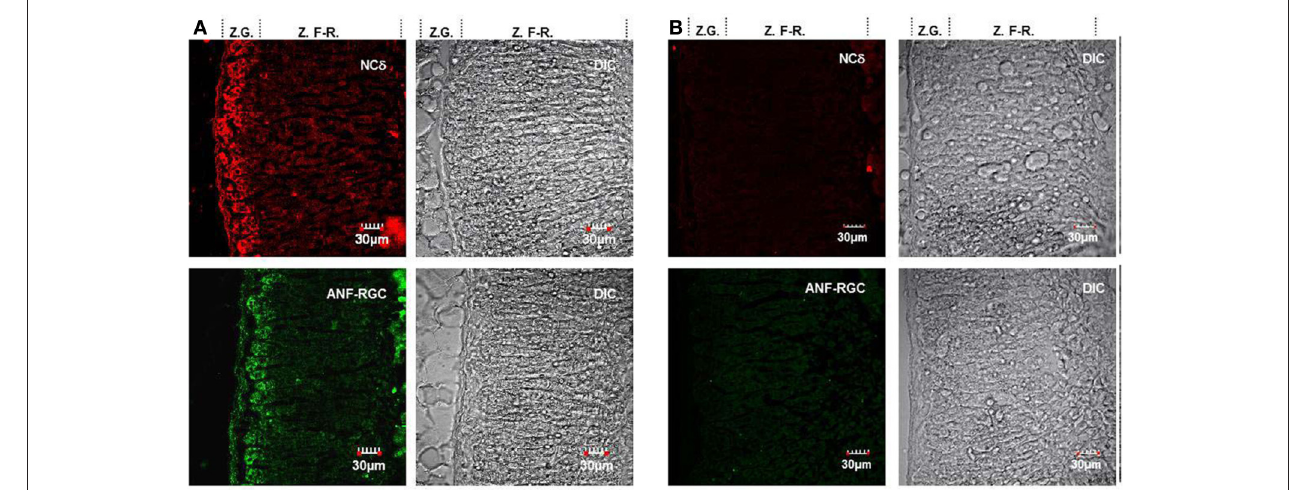
FIGURE 4 | ANF-RGC and neurocalcin δ are co-expressed in the glomerulosa cells of mouse adrenal gland. (A) Serial cryosections of the mouse adrenal gland were immunostained with neurocalcin δ (panel “NC δ ”) or ANF-RGC (panel “ANF-RGC”) antibodies. The DIC image showing the integrity of the adrenal gland sections are presented at the left (“DIC”). “Z.G.” and “Z.F-R.” denote zona glomerulosa and zona fasciculata-reticularis, respectively. Intense staining with either antibody was observed